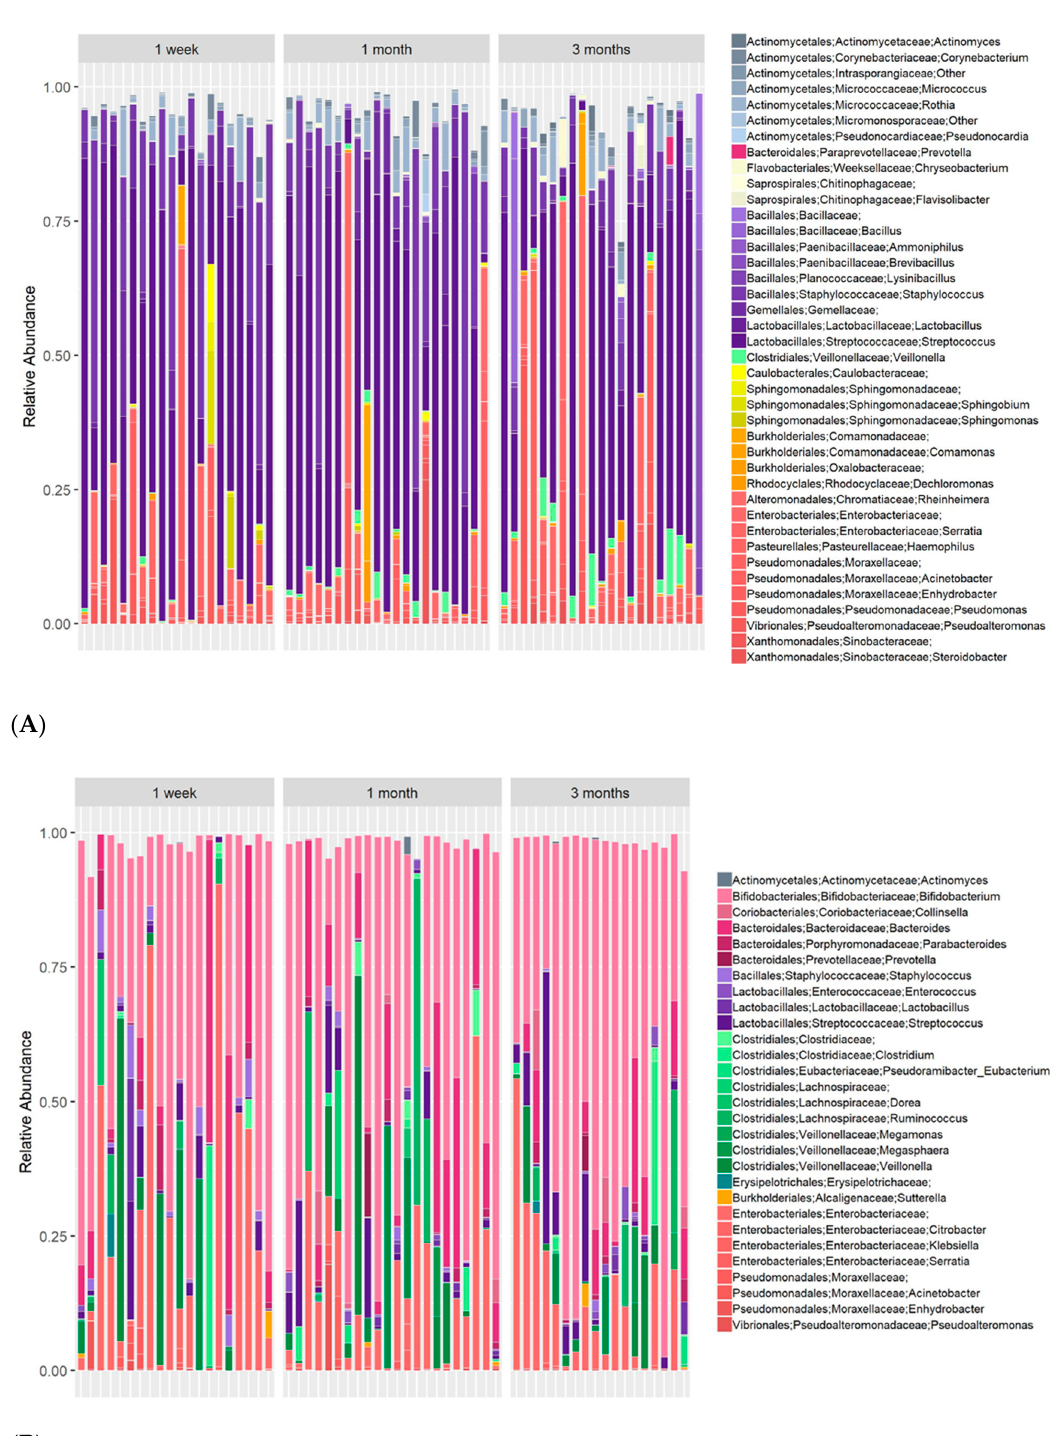
Figure 1. Per-subject longitudinal taxonomical profiles. ( A ) Maternal milk microbiome; ( B ) Fecal microbiome of corresponding infant. Genera whose abundance was <0.03% in all samples are not shown.